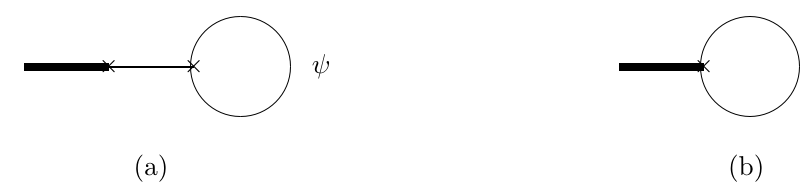
Figure 4 . The two Feynman diagrams involving the loop of the out-of-Siegel-gauge mode ψ . They both involve the upper half plane C-O-O amplitude; (a) corresponds to small β while (b) corresponds to finite β . Figure adapted from